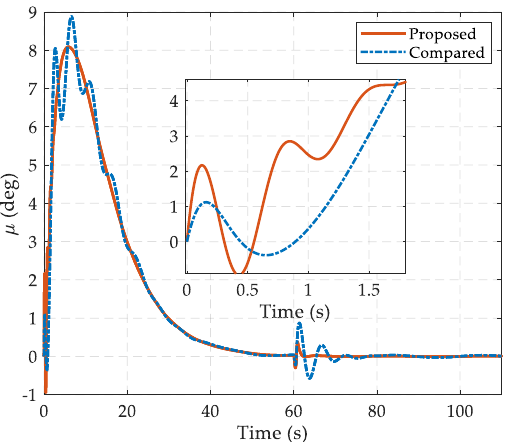
Figure 4. The curves of flight path angle μ in the comparative simulations.